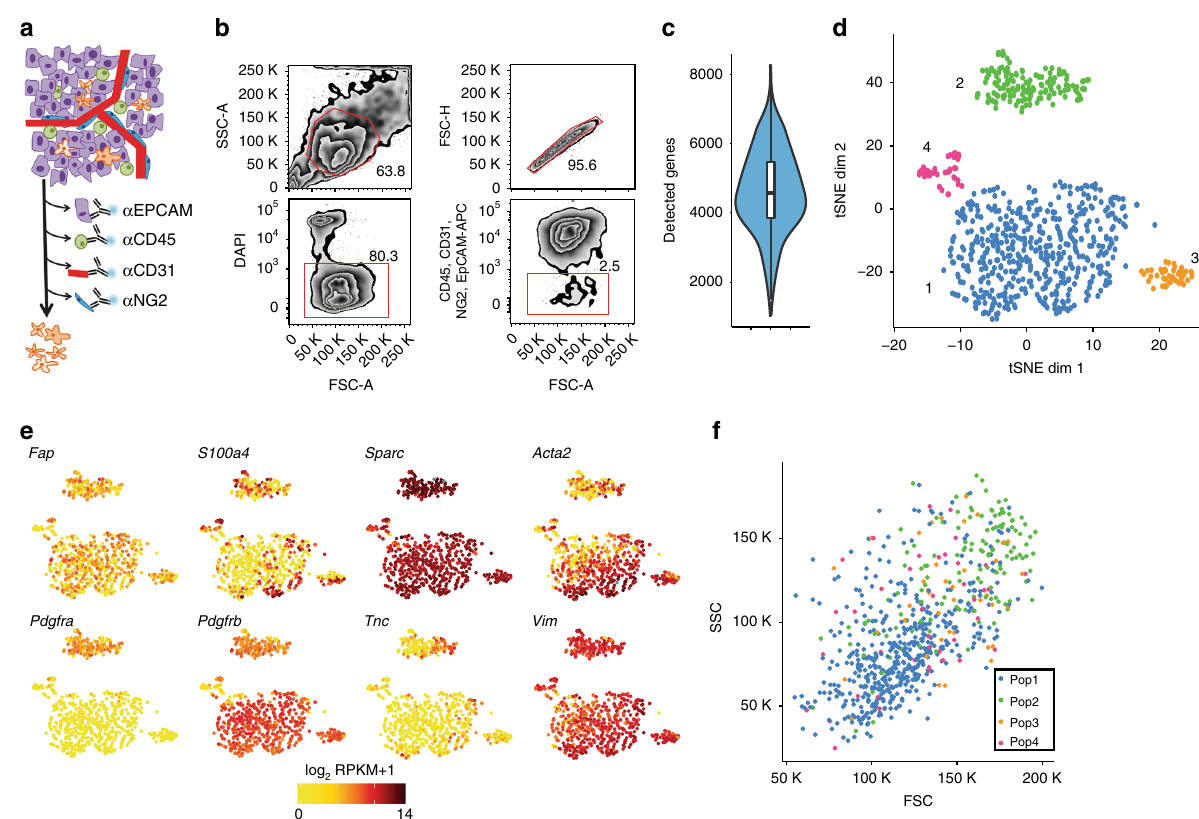
Fig. 1 Unbiased clustering of fi broblast single cell transcriptomic data reveals four populations. a Schematic representation of negative selection strategy removing CD31 + , CD45 + , NG2 + , and EPCAM + cells. b Gating strategy and quanti fi cation of fl ow cytometry for single cell sequencing. After gating out doublets and DAPI + dead cells, EpCAM − CD31 − CD45 − NG2 − CAFs made up 2.5% of the cells. FSC forward scatter, SSC side scatter. For single marker staining see also Supplementary Figure 1. c Violin plot of detected genes in 784 sorted fi broblasts. d t -SNE layout of CAFs ( n = 716) by RPKM-normalized transcriptomic data. Colors represent clusters assigned by DBSCAN. e Expression plots on t -SNE layout. log 2 (RPKM + 1) levels of CAF marker genes in individual cells. f Cell size and granularity as determined by forward-scattered light (FSC) and side-scattered light (SSC) of different CAF